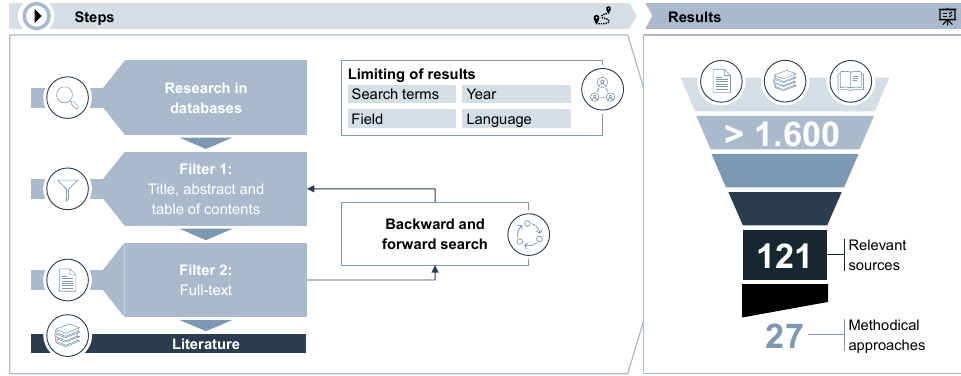
Figure 1. Overview of the systematic literature review analysis approach and the results. Table 1. Inclusion criteria for the systematic literature